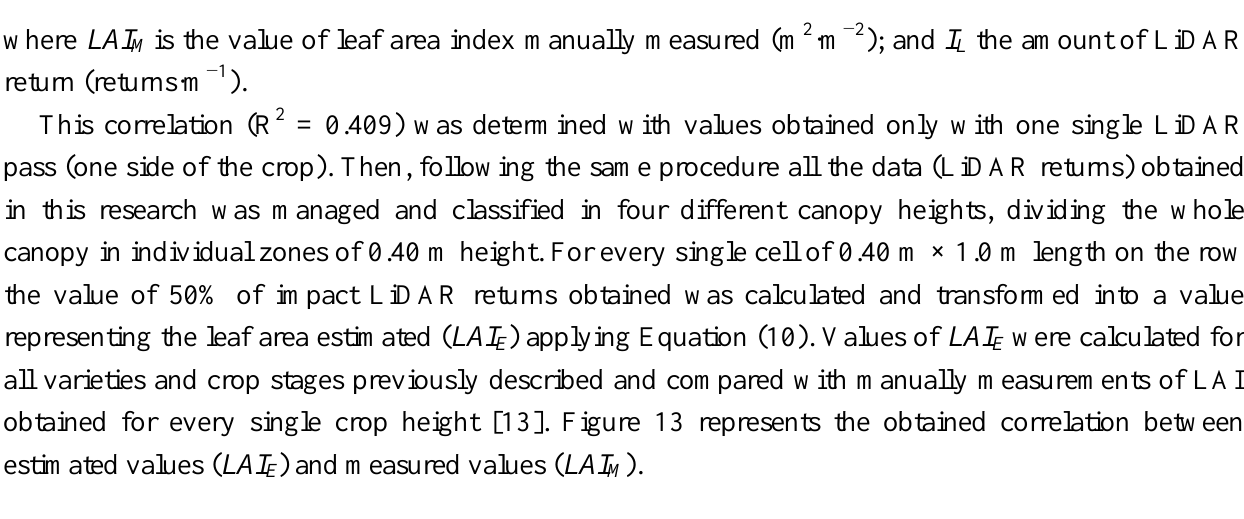
) obtained from LiDAR E ). Values represent all the varieties M